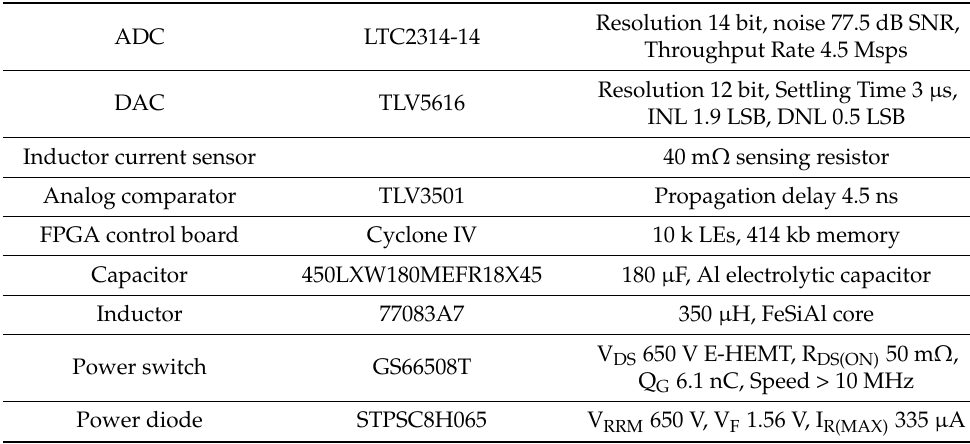
Table 2. Detailed specifications of